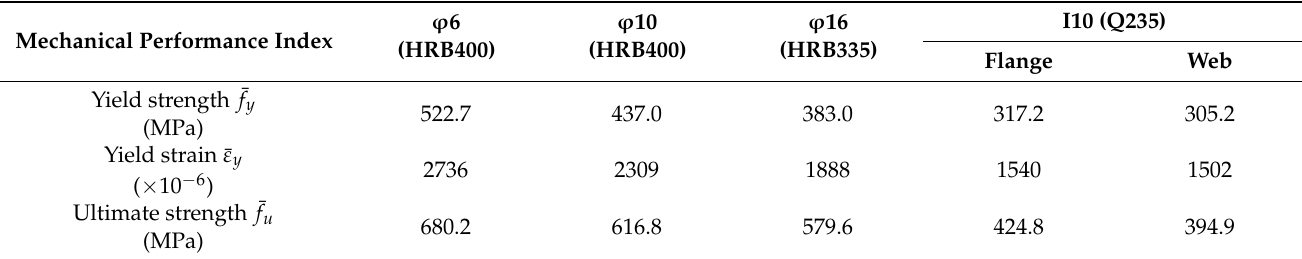
Figure 1. Geometry and reinforcement details of test specimens (units: mm).